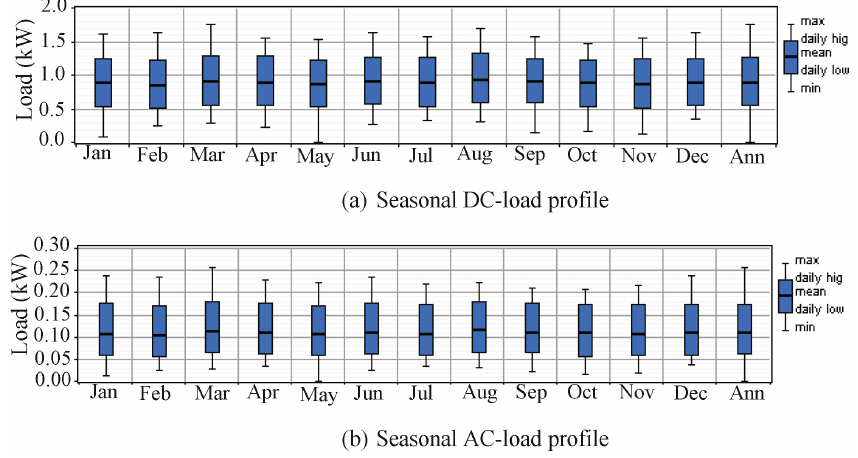
Figure 10. Seasonal load profiles: ( a ) DC-load profile; ( b ) AC-load profile.